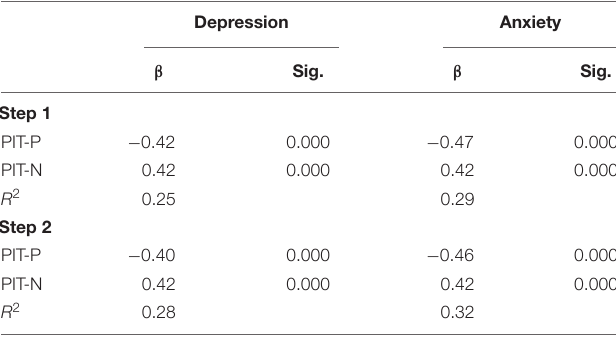
Positive; PIT-N, Prospective Imagery Task-Negative. TABLE 5 | Area under the curve (AUC) of PIT. Area Std. error Sig. Asymptotic 95%